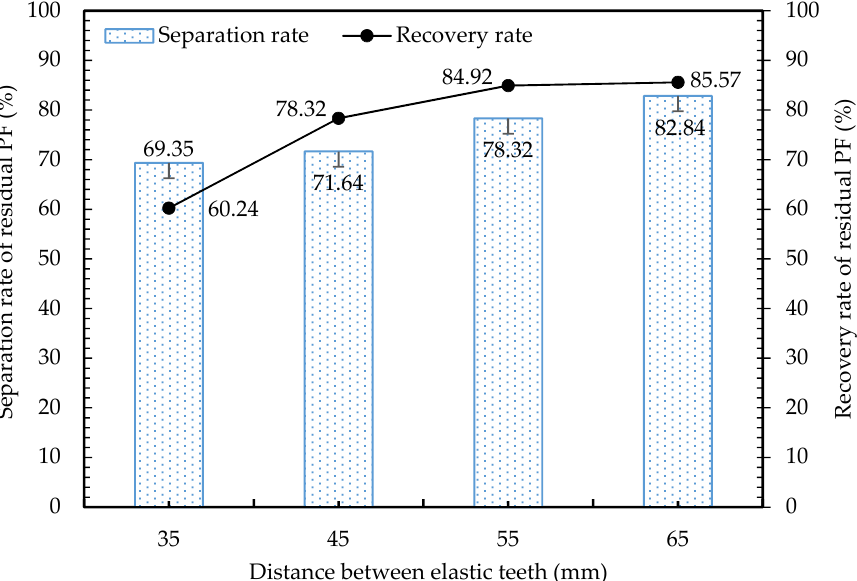
Figure 8. Effect of the distance between elastic teeth (mm) on the recovery and separation rate of residual PF (%) when the rotational speed and inclination angle of the conveying and separating device were 74 rpm, 35° and 120 rpm, 45°, respectively.